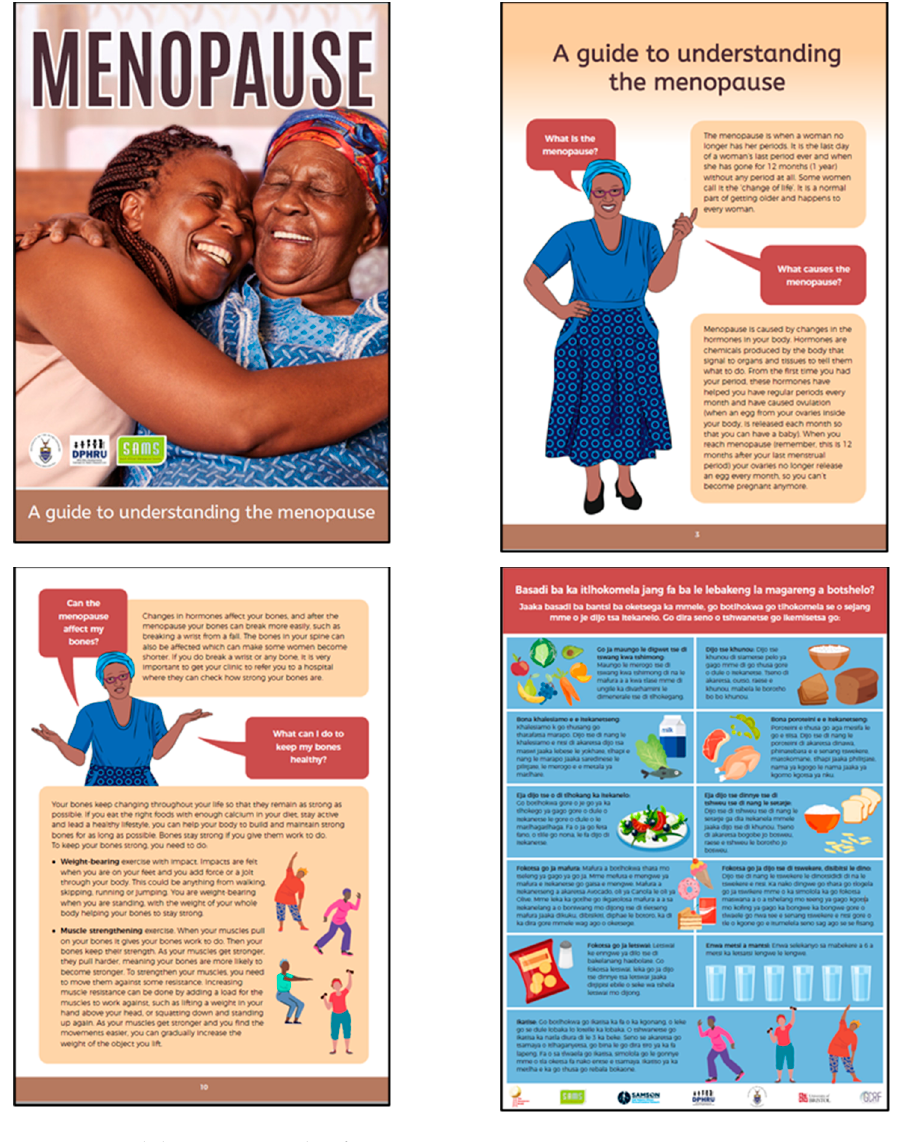
Figure 3. Final designs in South Africa.